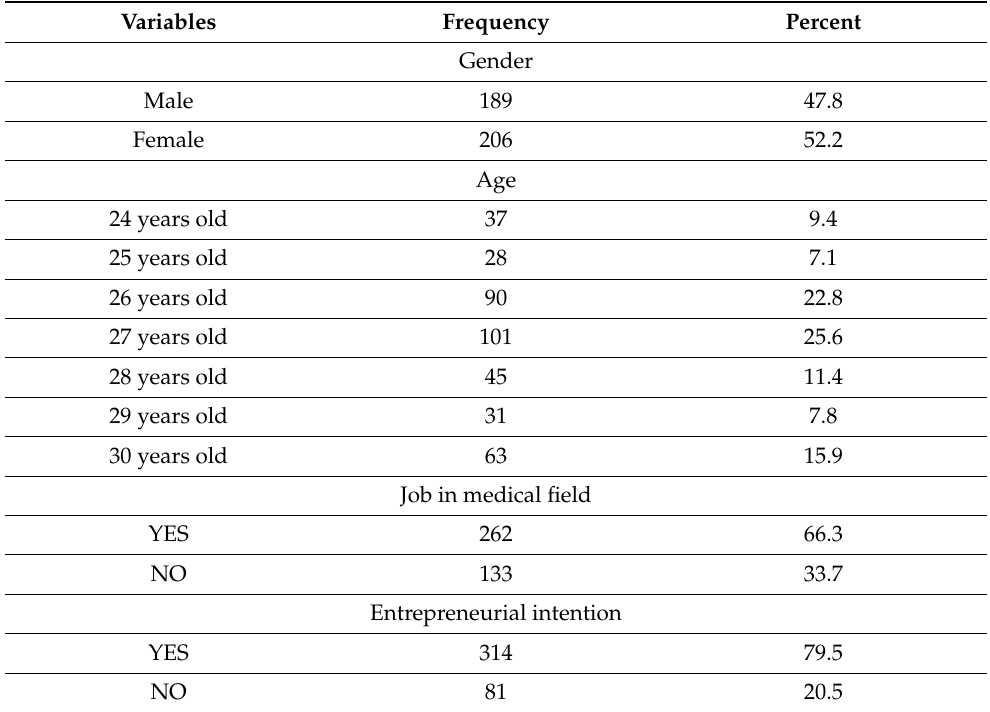
Table 1. The structure of the sample.